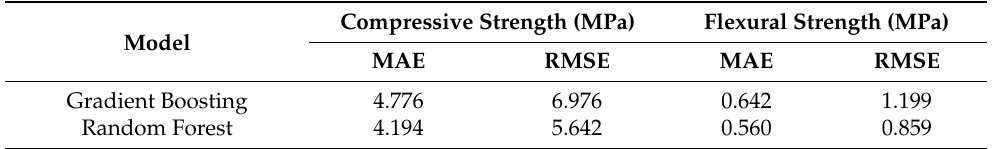
Table 3. Statistical measurements of the models for validation.